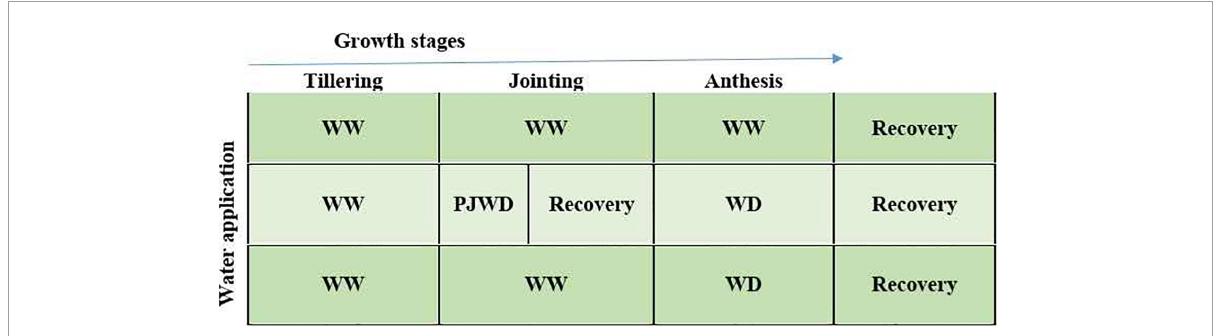
FIGURE1 Experimental plan for the study: drought priming (P) was applied at jointing (J) by exposing the plants of two wheat cultivars (Yangmai-158 and Yangmai-22) to moderate drought stress at 55–60% field capacity (FC) for 10 days followed by re-watering. Meanwhile, non-priming plants (WW) were subjected to continued watering at 75–80% FC. At the post-anthesis stage, moderate drought stress at 55–60% FC was applied from 7 to 14 days after post-anthesis followed by re-watering. The treatments during post-anthesis drought stress were assigned as PJWD priming at jointing + post-anthesis drought stress, WD no priming at jointing + post-anthesis drought stress, and WW no priming at jointing + no post-anthesis drought stress. After priming at jointing and application of post-anthesis drought stress treatments, the plants were re-watered directly at 75%–80% FC for